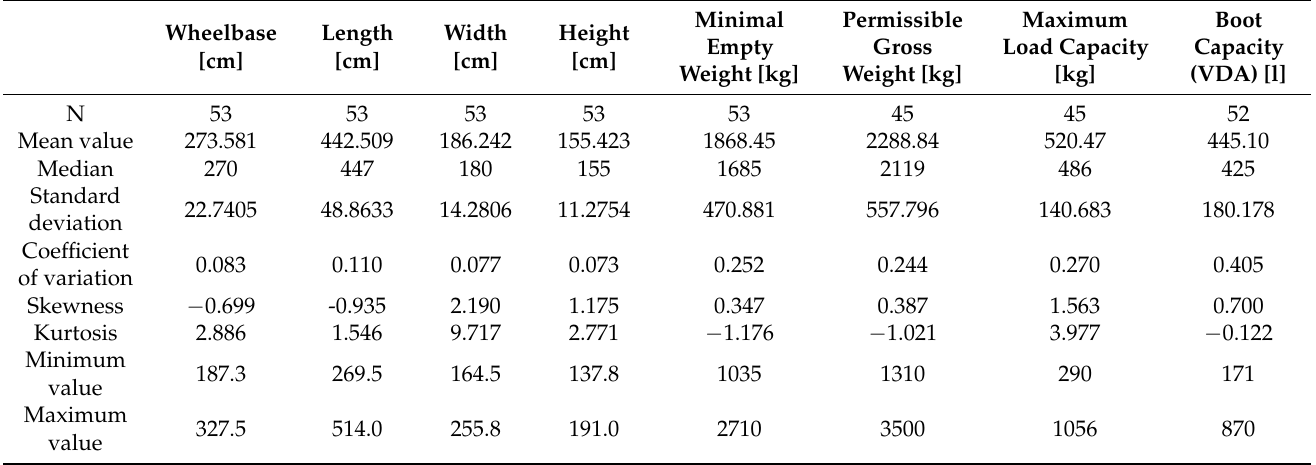
Table 3. Descriptive statistics for extracted size group.